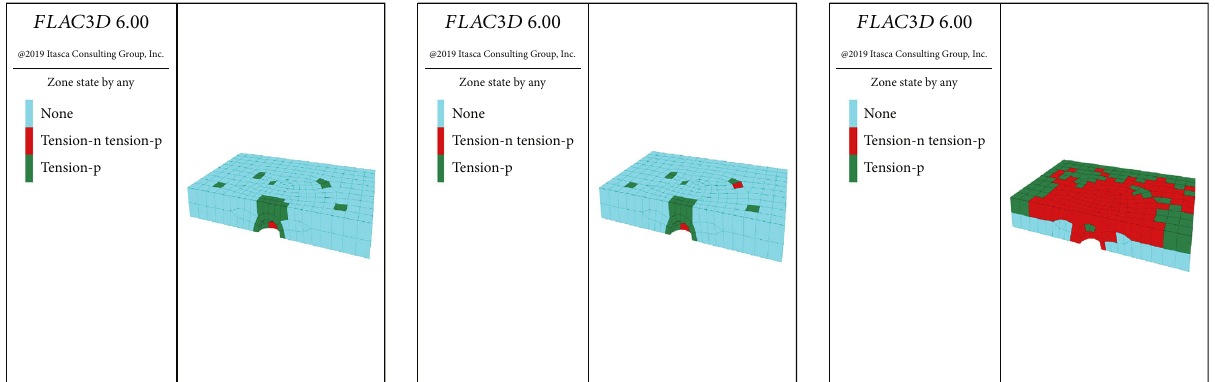
Figure 14: Variation of plastic zone development during the dropping process with initial water level heights of 0 mm, 25 mm, and 100mm, respectively.